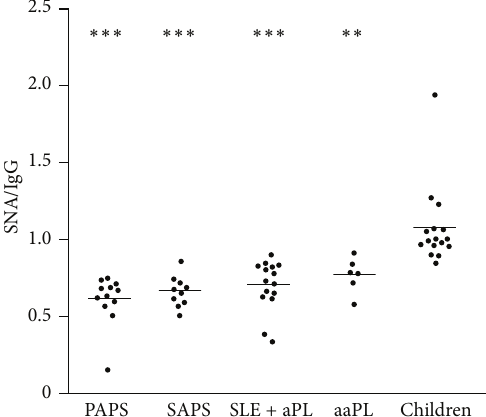
Figure 4: SNA/anti- 𝛽 2GP1-IgG ratio in PAPS, SAPS, SLE + aPL, aaPL, and children. Healthy children show a significantly higher SNA/anti- 𝛽 2GP1-IgG ratio than PAPS, SAPS, SLE + aPL, and aaPL ( ∗∗ 𝑝 < 0.0001 ; ∗∗∗ 𝑝 < 0.00001 ). This suggests higher sialylation of the oligosaccharides attached to Fc fragments of the children’s anti- 𝛽 2GP1.Nosignificantdifferenceswerefoundbetweentheremaining cohorts. Horizontal lines indicate the mean SNA/IgG ratio of the cohort. SNA = Sambucus nigra agglutinin; APS = antiphospholipid syndrome; PAPS = patients with primary APS; SAPS = patients with APS and SLE as underlying disease; SLE + aaPL = patients with SLE without symptoms of APS harbouring circulating aPL; aaPL = asymptomatic carriers of aPL; aPL = antiphospholipid antibodies; SLE = systemic lupus